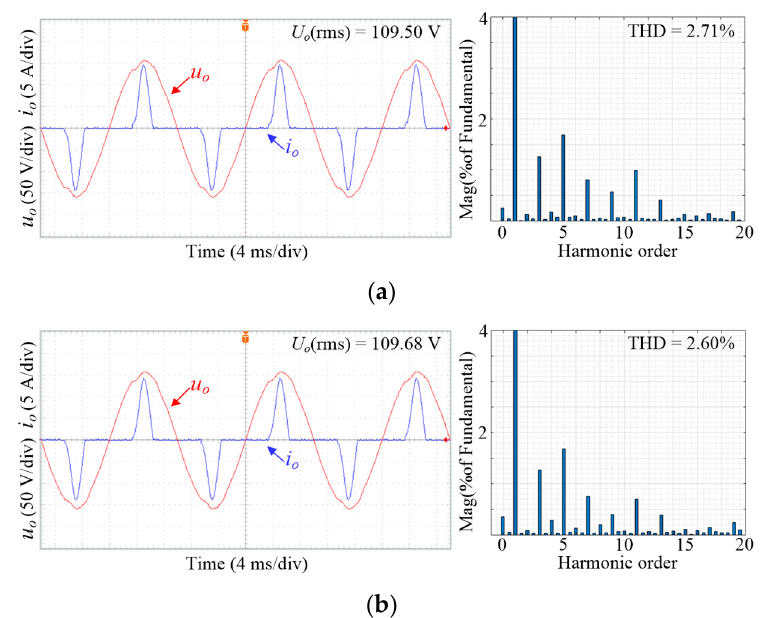
Electronics 2023 , 11 , x FOR PEER REVIEW Figure 19. Steady-state waveforms of SRFPI-LADRC with different mismatch factor of L under nonlinear load. ( a ) L A / L = 0.8, ( b ) L A / L = 1.2.